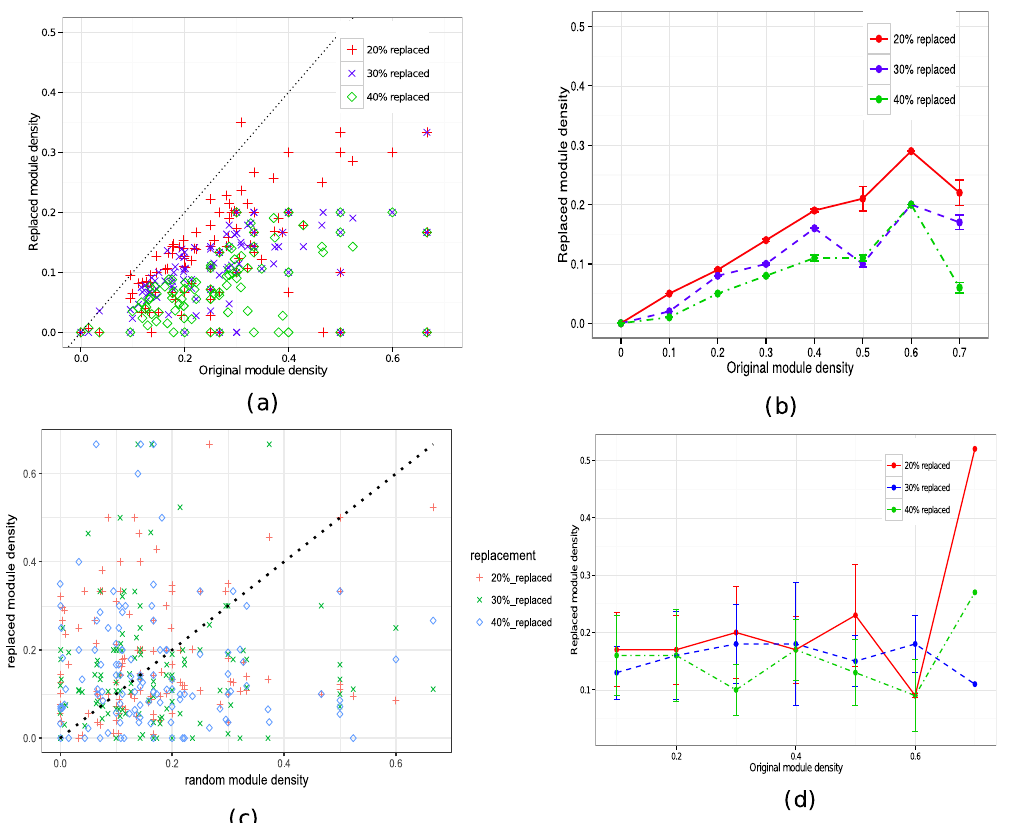
Figure 4. Comparing the density of original modules and newly constructed modules for Gavin dataset. ( a ) Each point in the scatter plot represents the density of an original module (x-axis) and newly constructed module (y-axis). The dashed line (y = x) indicates the points where the connectivity density is the same for the original module and replaced module. Any data point above the line corresponds to the case where the replaced modules have higher connectivity density, while data points below the line represent the case where the replaced module has lower connectivity density than the actual functional module. ( b ) Shows the summary statistics - the vertical axis shows the density of the original modules and the horizontal axis shows the average density of the replaced modules with standard deviation. Panel (c,d) shows the same for randomly constructed